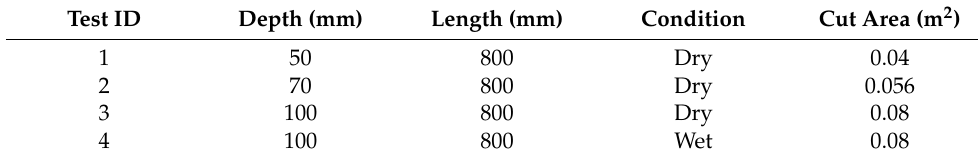
Table 4. Experimental